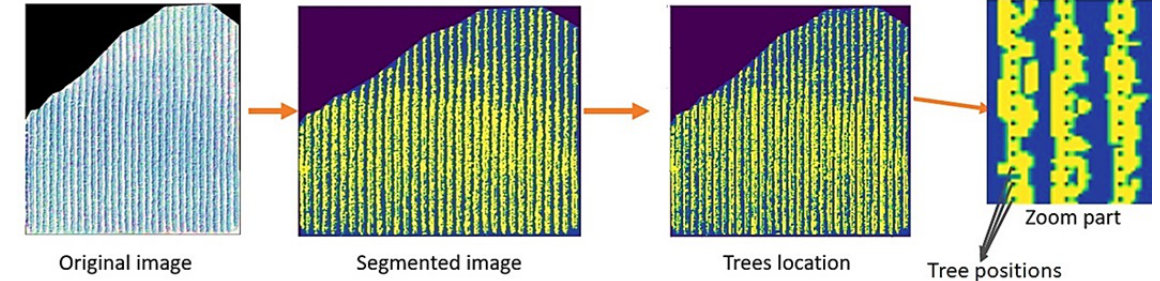
Figure 7. Tree localization and distribution in the